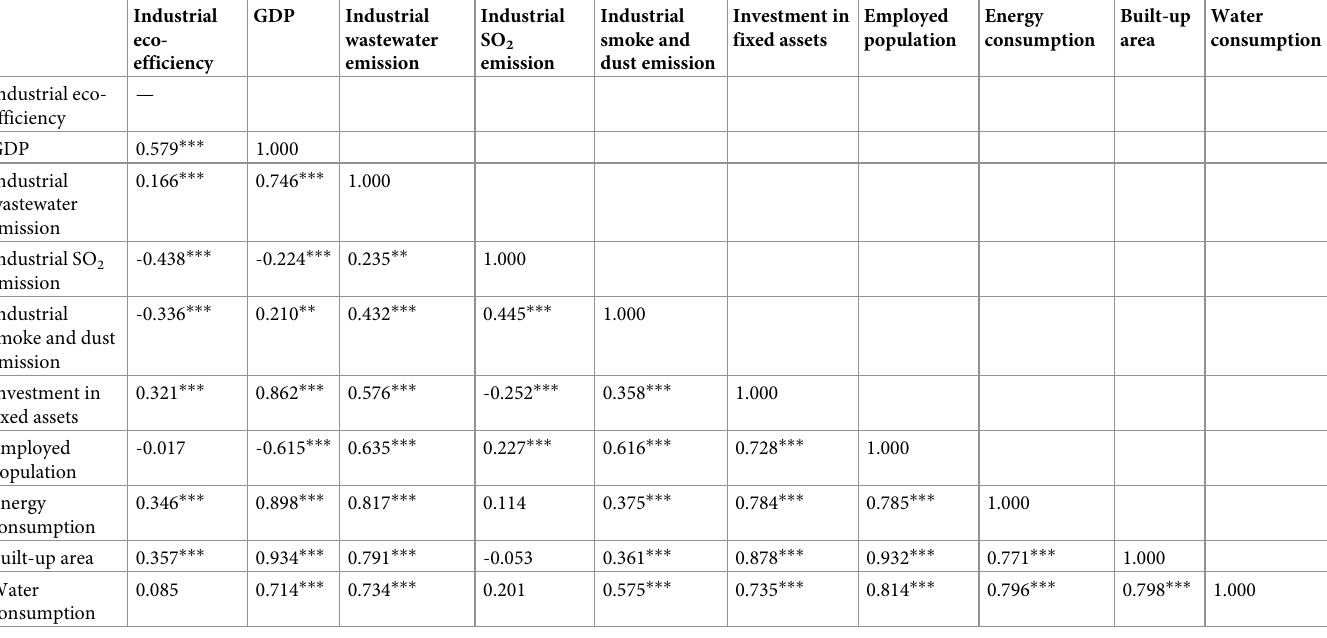
Table 2. Correlation coefficient and p value of input—output